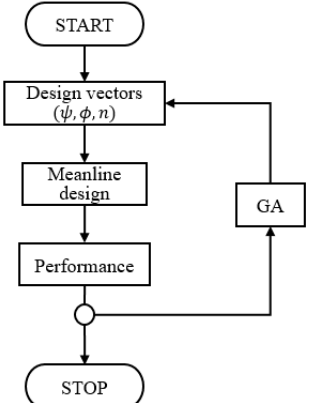
Figure 5. Flowchart of GA assisted preliminary design procedure.